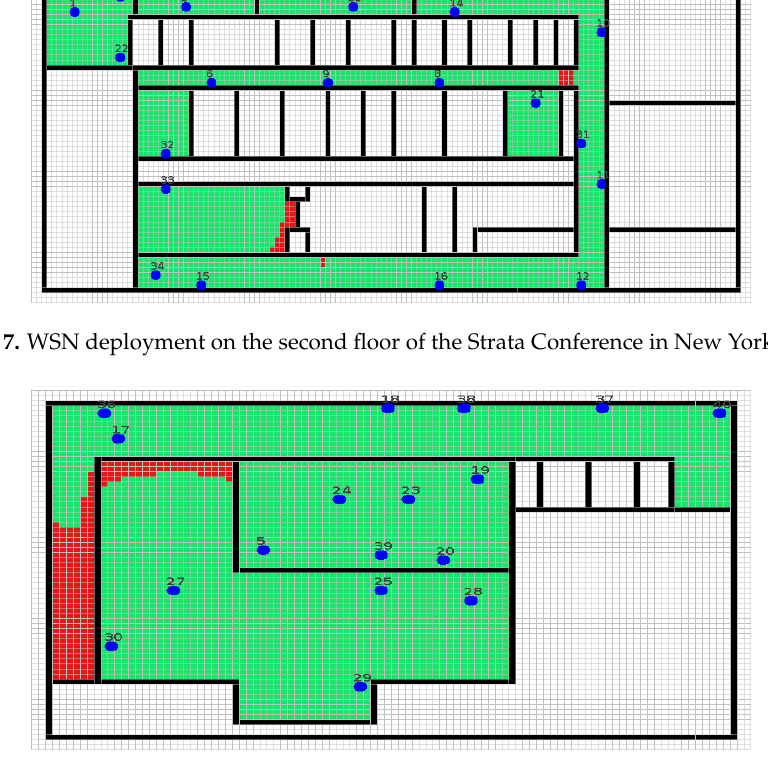
Figure 8. WSN deployment on the third floor of the Strata Conference in New York